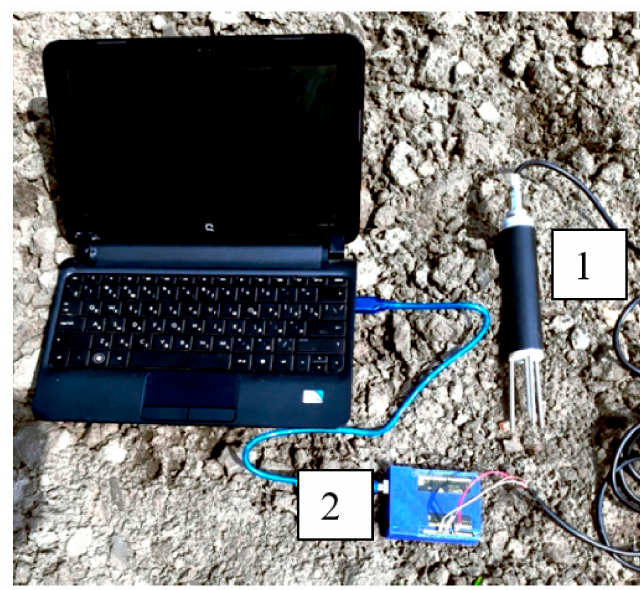
Figure 2. Soil moisture measuring kit: 1—SHS-1; 2—Arduino Uno.